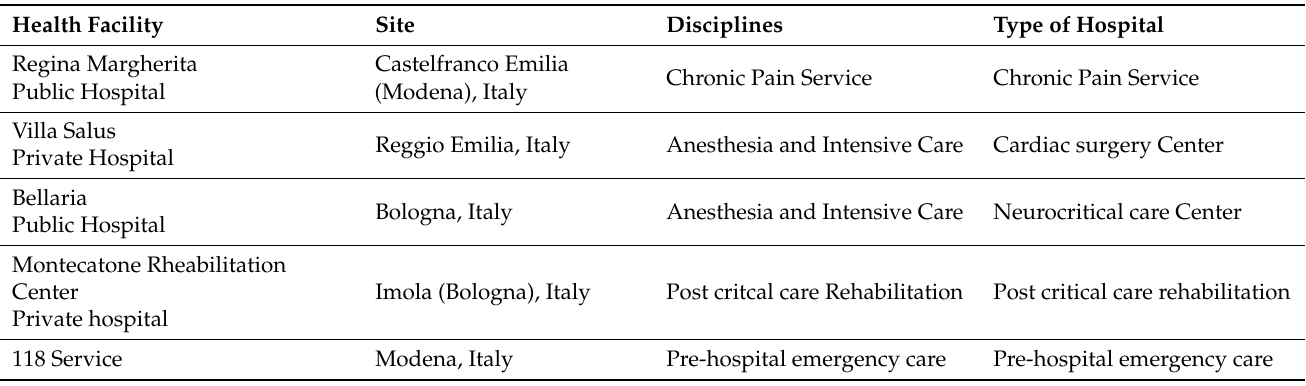
Table A2. School of Anesthesia and Intensive Care network of University of Modena and Reg- gio Emilia.